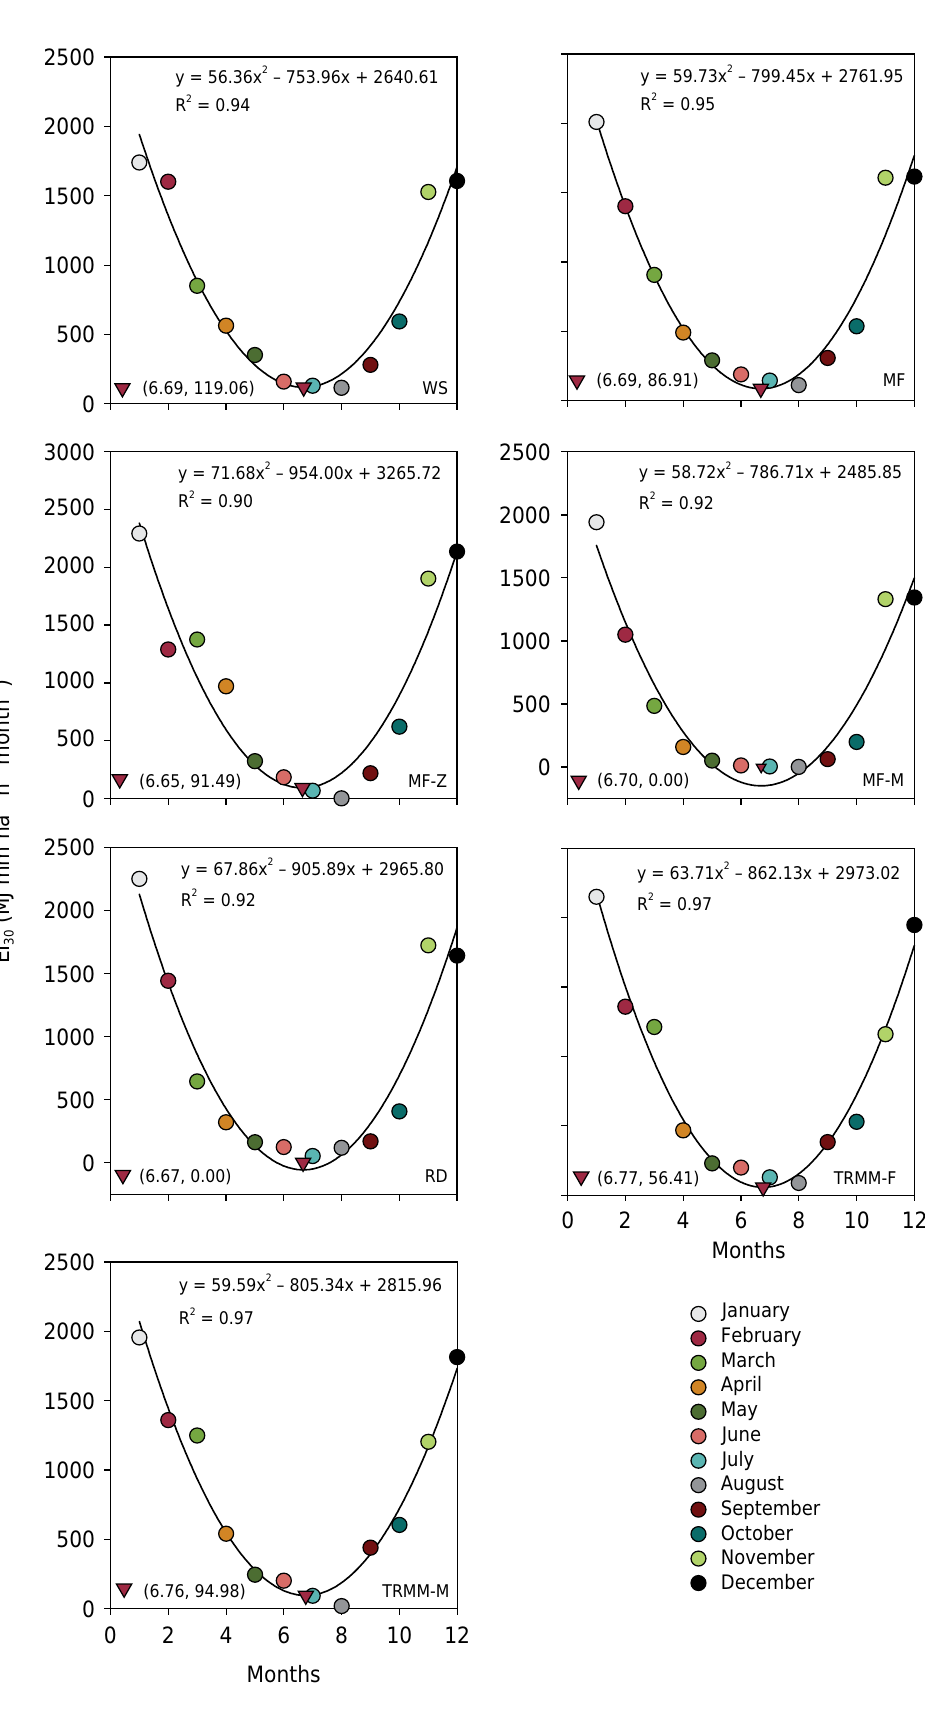
Figure 3. Adjusted equations, coefficients of determination, critical points, and rainfall erosivity indexes (EI 30 , MJ mm ha -1 h -1 month -1 ) corresponding to critical point for the evaluated methods (WS, MF, MF-Z, MF-M, RD, TRMM-F and